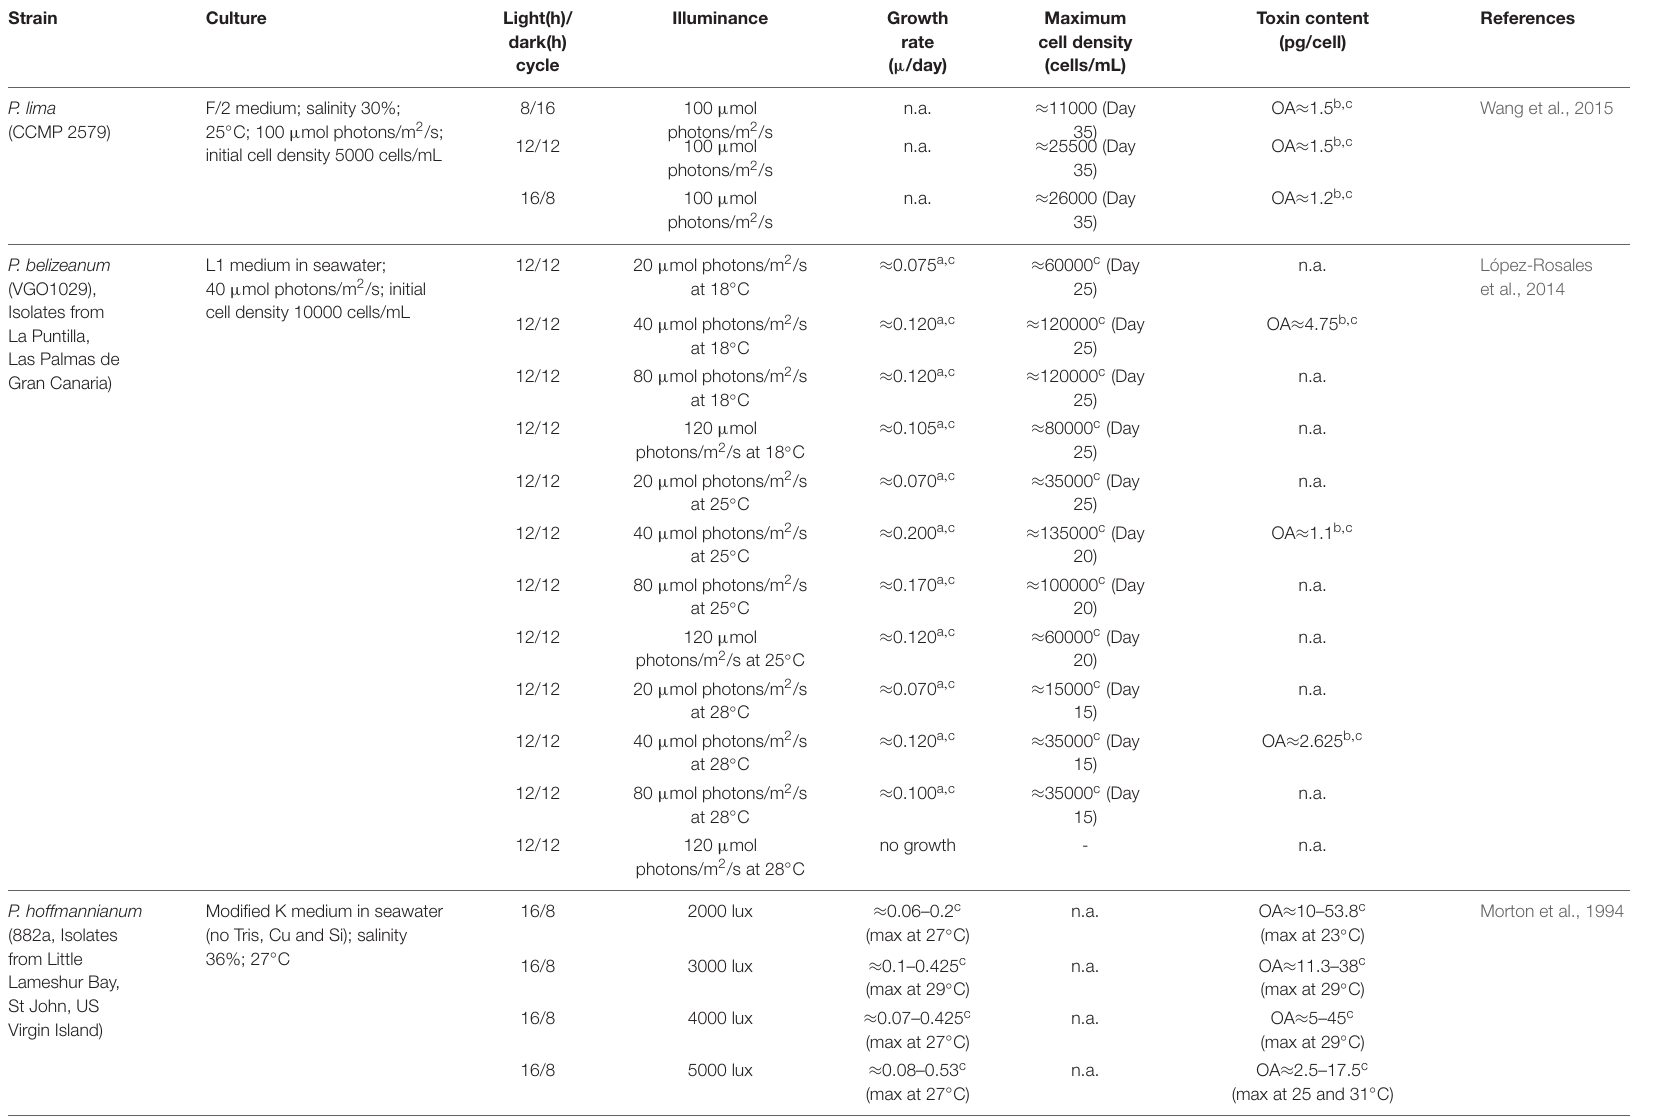
TABLE 3 | Effect of light on the growth and toxin content of Prorocentrum spp.